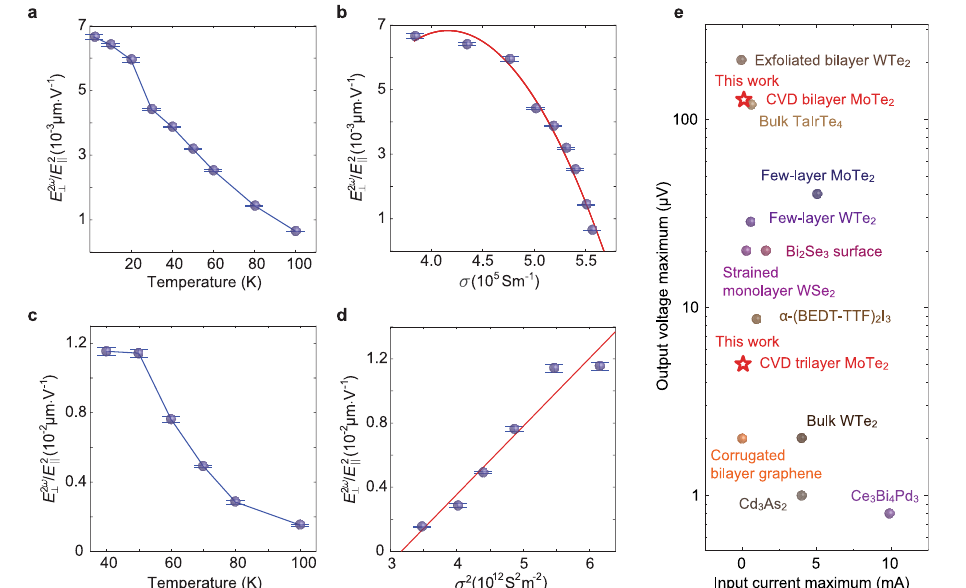
experimental data are shown with error bars (some are smaller than symbols) obtained by linear regression for the relation of E 2 ω ? on E 2 ∣∣ at each temperature. e , Input current-output nonlinear Hall effect voltage map of materials with non- linear Hall effect for